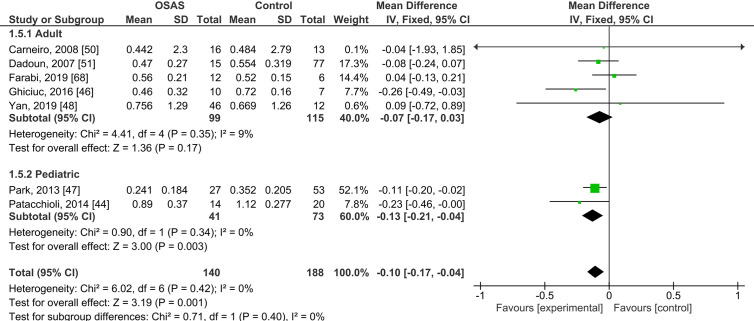
Forest plot of random-effects analysis of salivary cortisol levels in adult and pediatric obstructive sleep apnea syndrome (OSAS) versus the control group. The diamond shape indicates the pooled mean difference (MD). Each black box represents a point estimate of each study and also gives a representation of the study size (the bigger the box, the more participants in the study). A horizontal line representing the 95% confidence intervals (CIs) of the study result, with each end of the line representing the boundaries of CI. SD, Standard deviation.